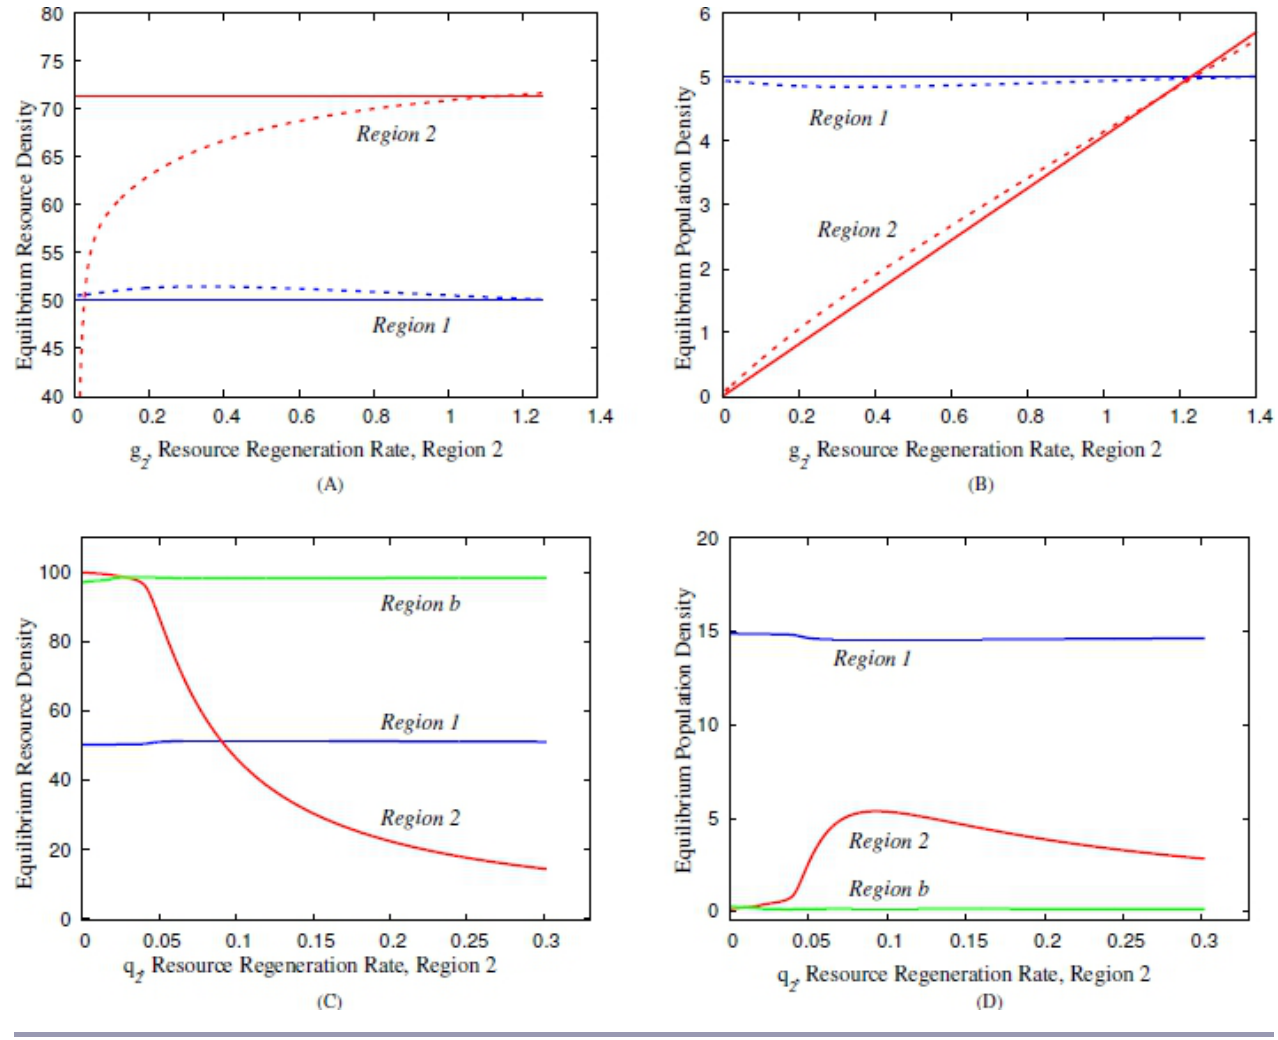
Fig. 5 . (A): Equilibrium resource density in Regions 1 and 2 (blue and red lines, respectively) as a function of g with and without migration (dashed and solid lines, respectively), with all other 2 parameters held constant. (B): Equilibrium human population density as a function of g parameters held constant (same color and line type interpretation as in A). (C)–(D) : Equilibrium resource and population density, respectively, in Regions 1 (blue), 2 (red), and b (green) as a function of q with 2